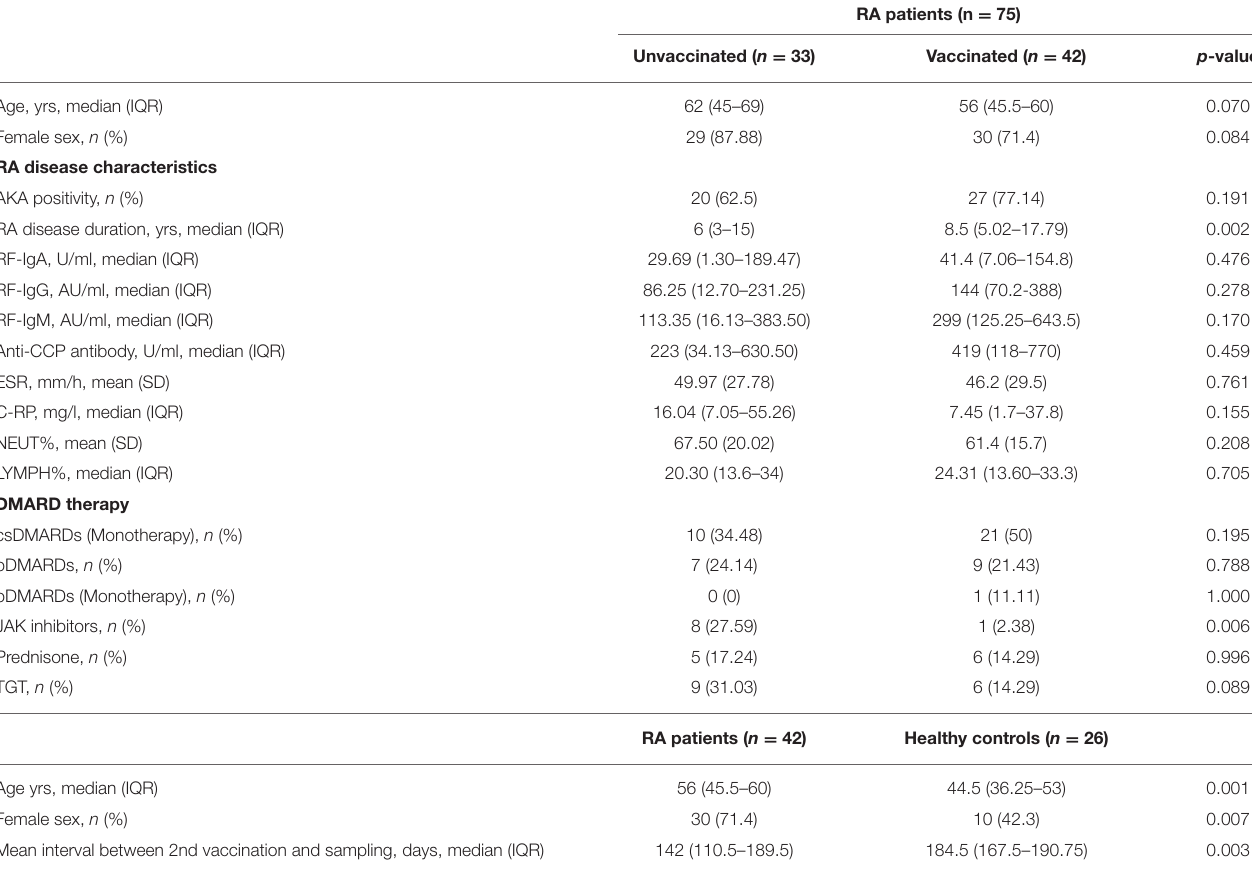
TABLE 1 | Baseline characteristics of unvaccinated and vaccinated RA patients, as well as vaccinated healthy